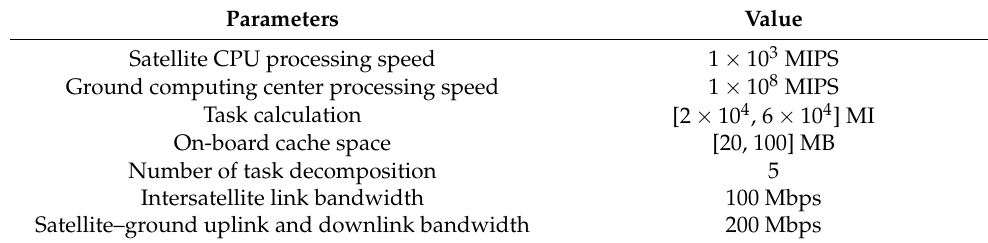
Table 1. Simulation parameter.